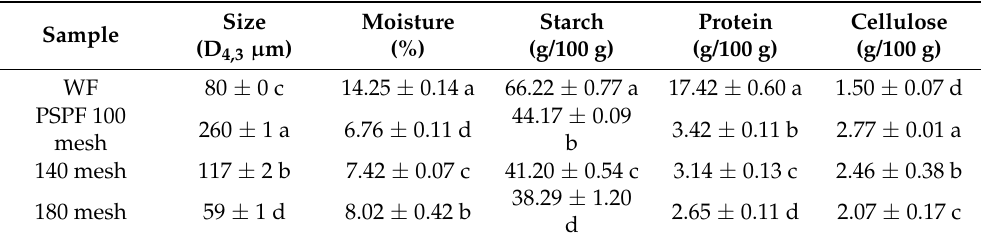
Table 1. Particle size distribution and nutrient distributions of WF and PSPF sieved through different sieves.